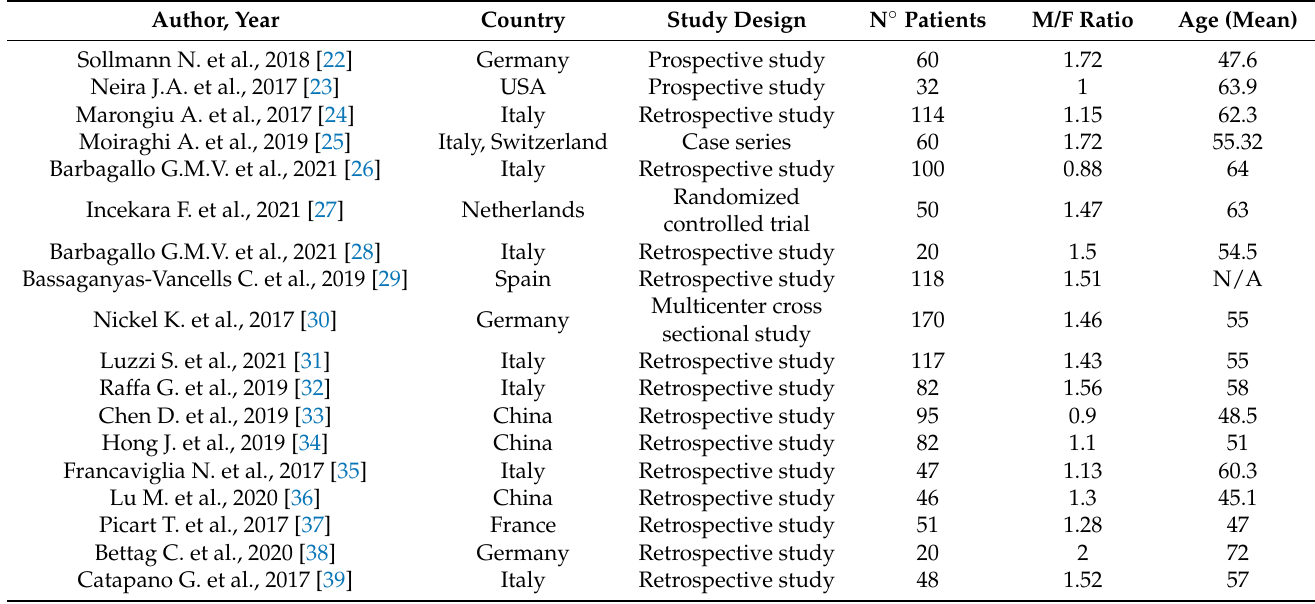
Table 1. Demographic and study design data included in